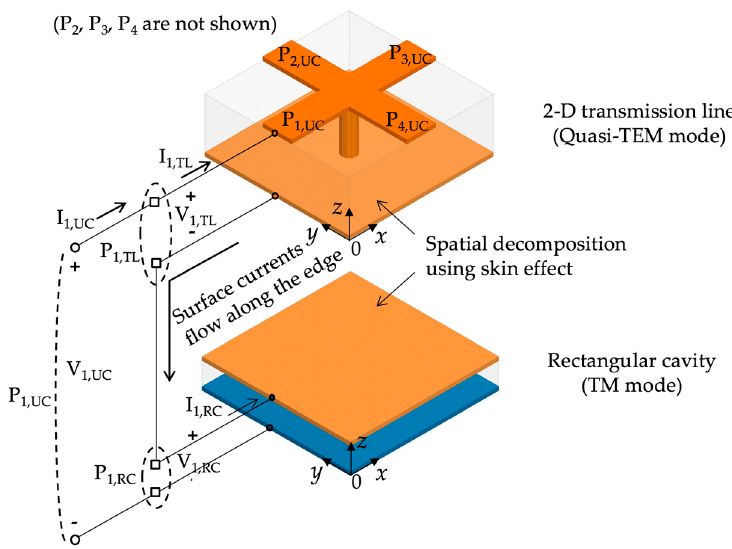
Figure 3. Spatial decomposition of the unit cell, divided into a transmission line mode and a resonant cavity mode.